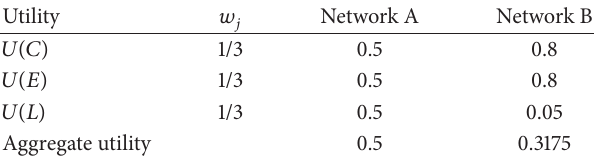
Table 4: Network selection based on MEW ( 𝑤 𝑙 = 1/3 ).